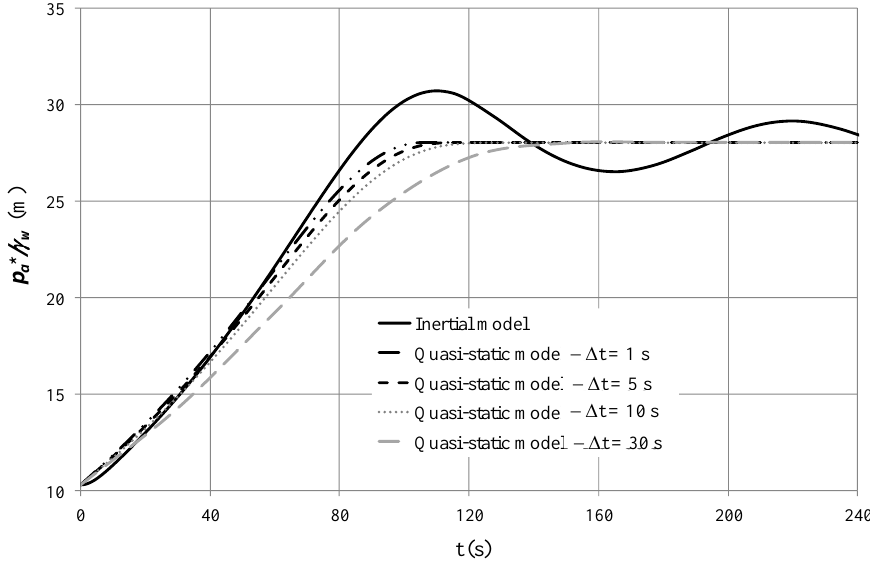
Figure 10. E ff ect of time step during a filling Figure 10. Effect of time step during a filling process.